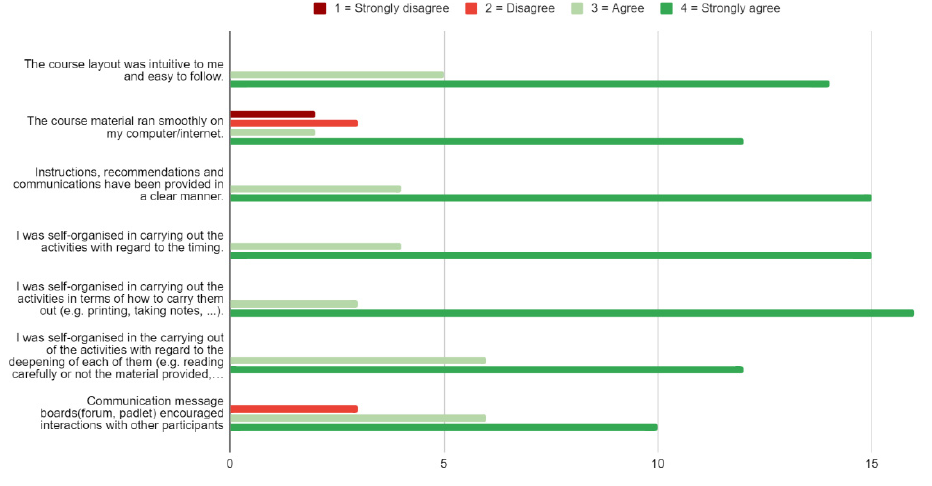
Figure 15. Different ratings concerning the MOOC organization and performance.